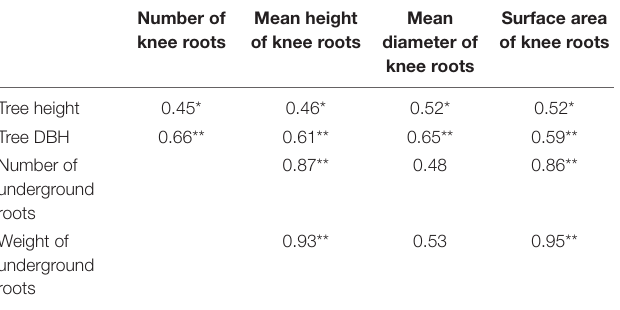
TABLE 2 | Correlation coefficient between number and size of knee roots and DBH and tree height of Taxodium ascendens at Zhaoguan Forest Farm. Number of Mean height Mean Surface area knee roots of knee roots diameter of of knee roots knee roots